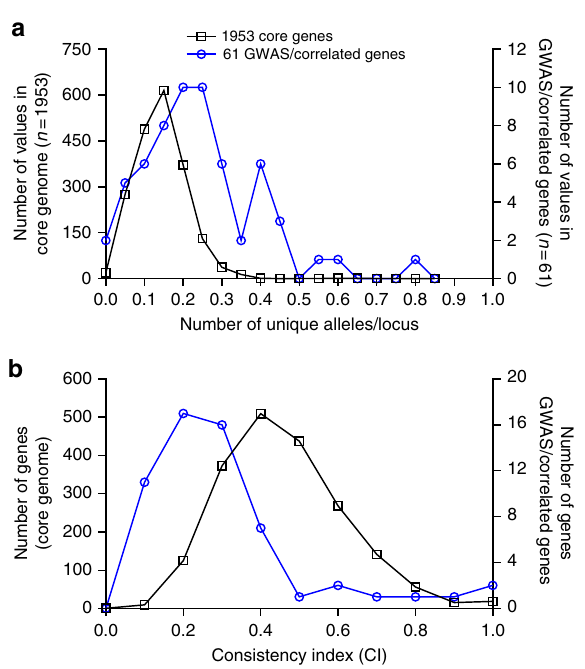
Fig. 4 Comparison of allelic variation and consistency index for core genes and genes containing GWAS pathogenicity elements. a The number of alleles per locus and b consistency indices to a core phylogeny, were calculated for each gene alignment for core genes and those containing pathogenicity-associated elements that correlated with secondary in vitro phenotypes using R and the phangorn package. The left y -axis indicates the number of core genes (black line), the right y -axis indicates the number of genes containing associated and correlated k-mers (blue line). For the consistency index, the two distributions were signi fi cantly different (two- tailed Mann – Whitney test; P = 0.002, Mann – Whitney U = illustrate the trade-off between true and false positives, the ROC curve based on the out-of-bag risk scores of the classi fi er is shown in Fig. 3k.